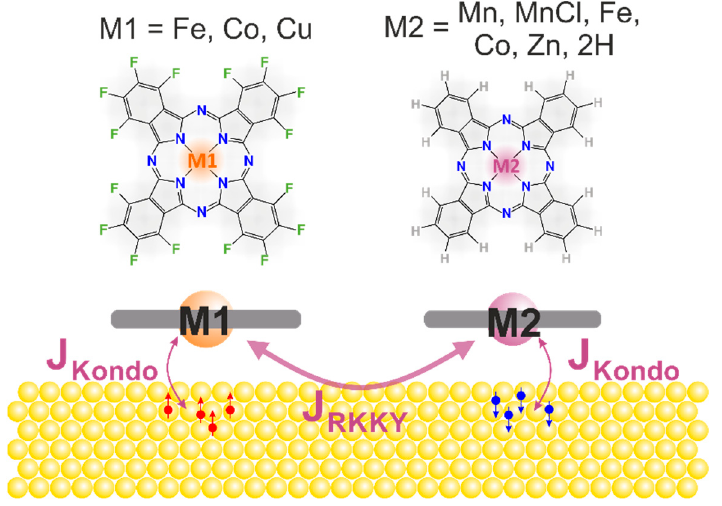
Scheme 1. Molecular structures ( top ) and schematic representation of 2D checkerboard assembly of phthalocyanine molecules on an Au(111) substrate, together with the involved competing interactions, namely RKKY and Kondo interactions ( bottom ).